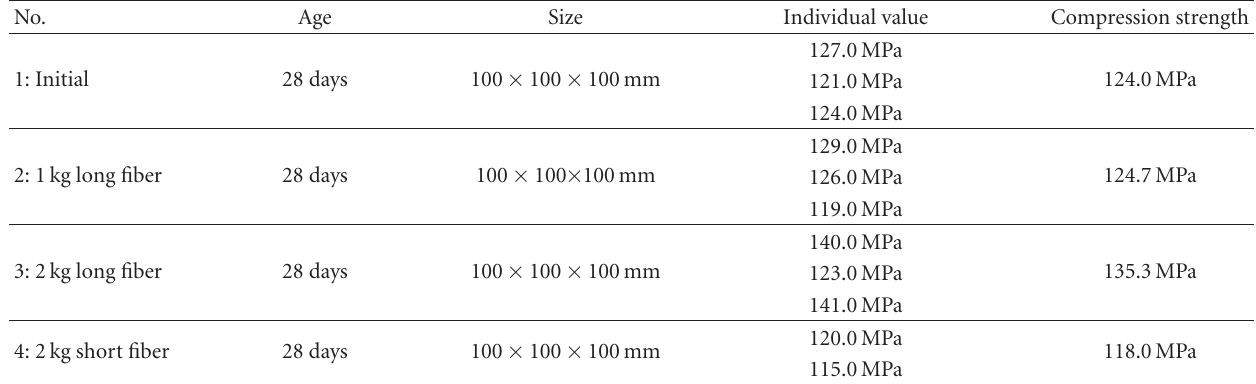
Table 2: Compressive strength test results of cube specimens.